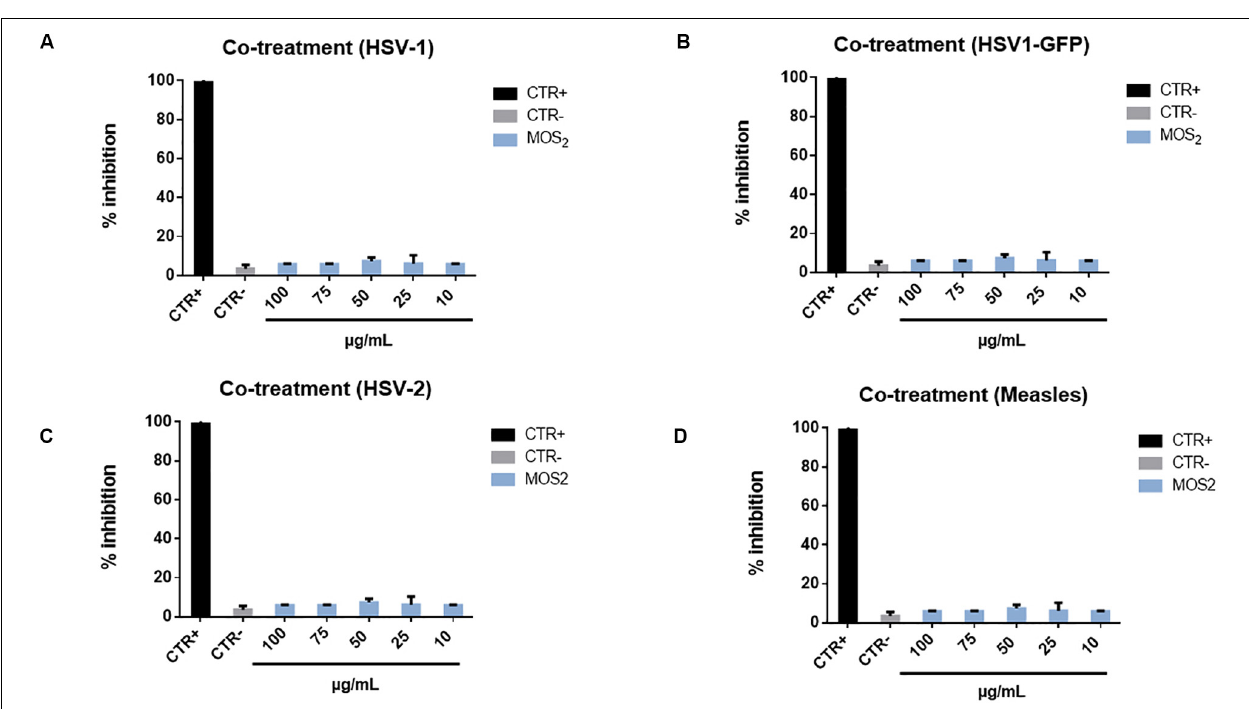
FIGURE 8 | Co-treatment with MoS 2 NSs and HSV-1-GFP, HSV-2 and Measles virus. Infectivity inhibition after treatment with MoS 2 nanosheets and HSV-1 (A) , HSV-1-GFP (B) , HSV-2 (C) , and measles virus (D) . No antiviral action was detected for any of the tested nanosheet concentrations. Not infected and not treated cells represented the positive control (CTR+), meanwhile infected cells were the negative control (CTR–). The data statistical error is the standard deviation of three independent experiments. P -value is less than